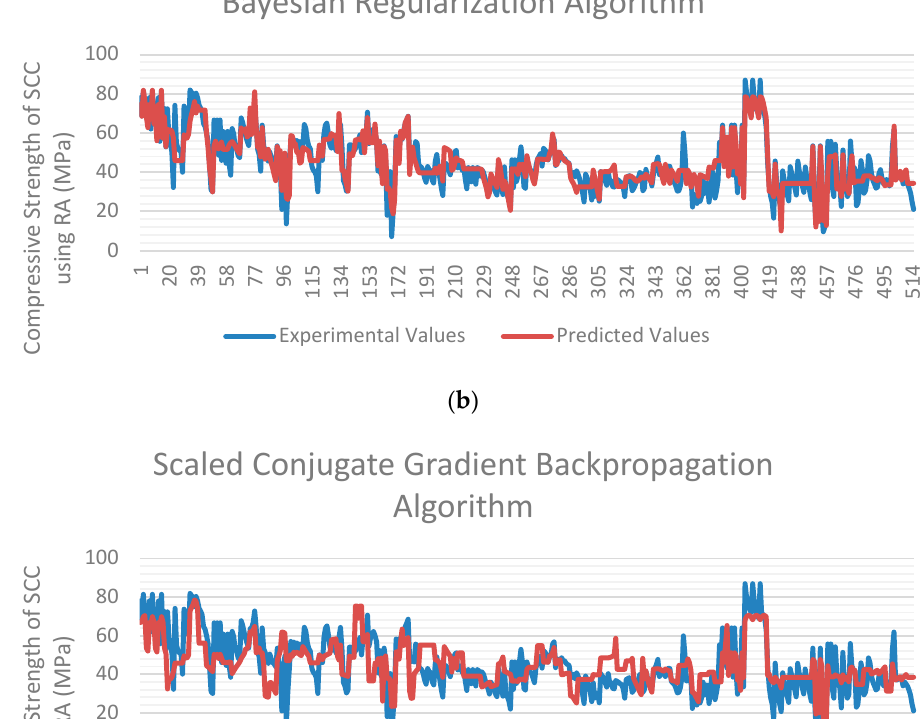
The higher discrepancy between the two lines shows the greater error between the